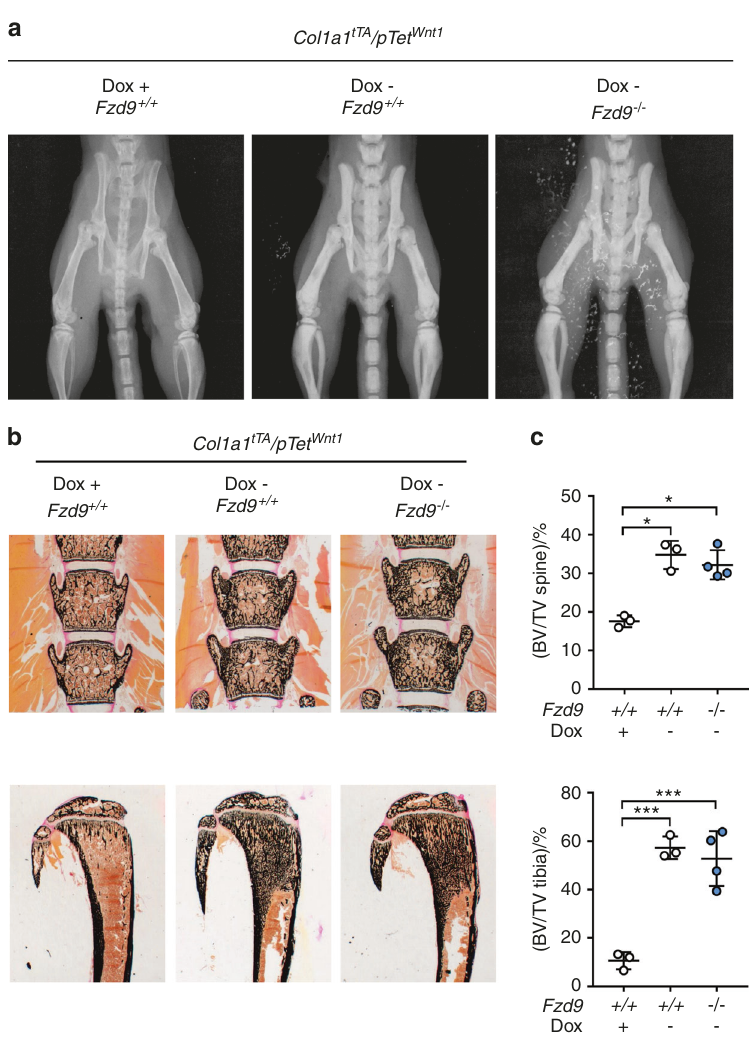
Fig. 6 FZD9 is dispensable for the osteoanabolic action of Wnt1 . a Representative contact X-rays of 6-week-old female Col1a1 tTA /pTet Wnt1 /Fzd9 + / + or Col1a1 tTA /pTet Wnt1 /Fzd9 − / − mice, in which Wnt1 expression was silenced (Dox + ) or activated by doxycycline removal for 1 week (Dox − ). b Representative undecalci fi ed spine and tibia sections from the same mice after von Kossa/van Gieson staining. c Trabecular bone mass, as determined by undecalci fi ed histology of the spine and tibia. Data were analyzed by two-way ANOVA with Sidak ’ s multiple comparison test (* P <0.05, ** P <0.01, *** P <0.001). Error bars indicate standard